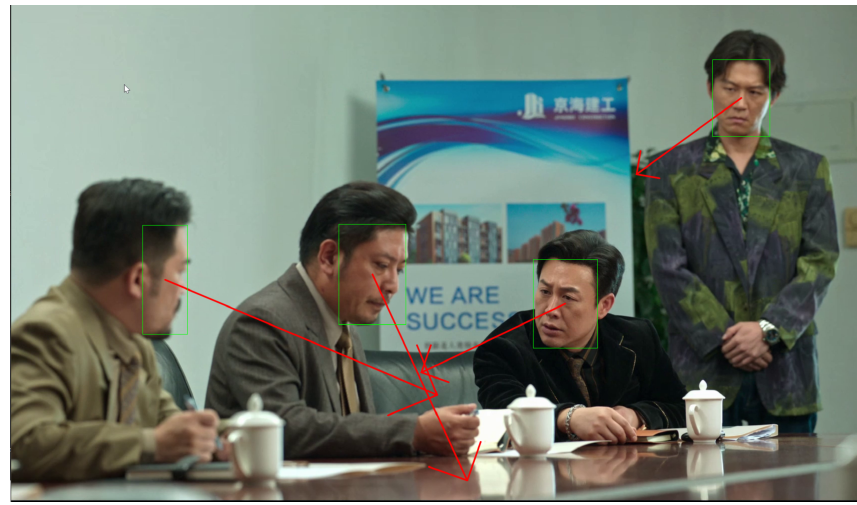
Figure 10. Gaze estimation in the video. The green frames represent the result of face detection and the red arrows represent the result of gaze